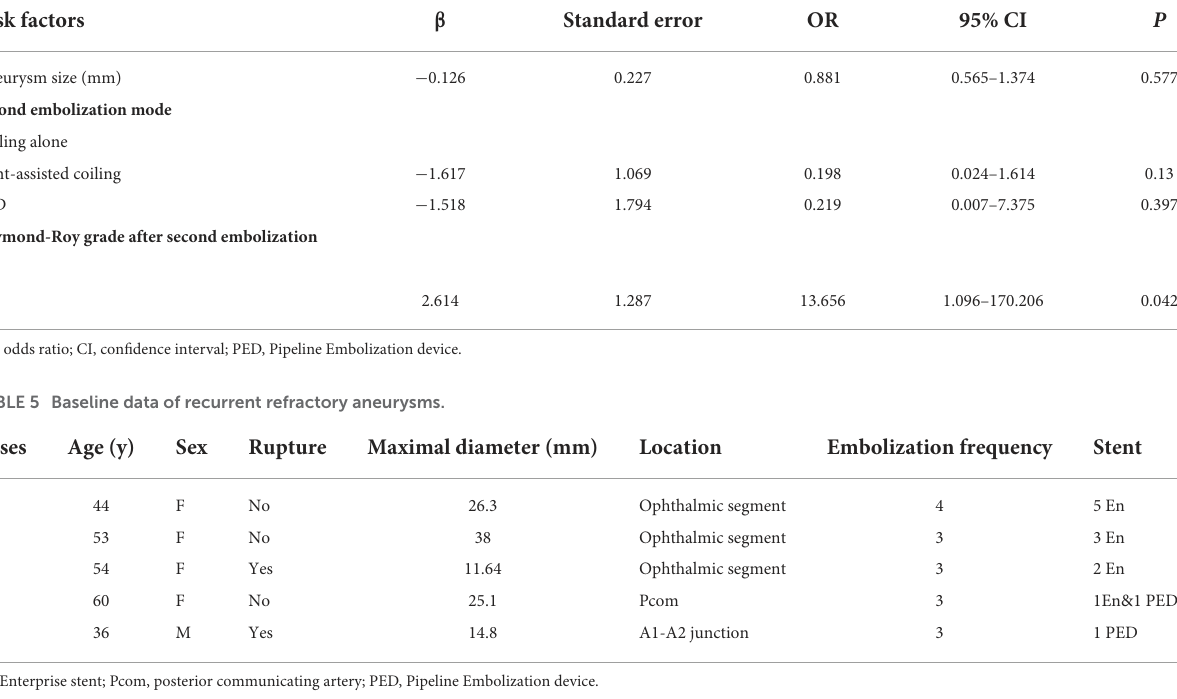
TABLE 6 Embolization method and occlusion degree immediately after embolization of recurrent refractory aneurysms.